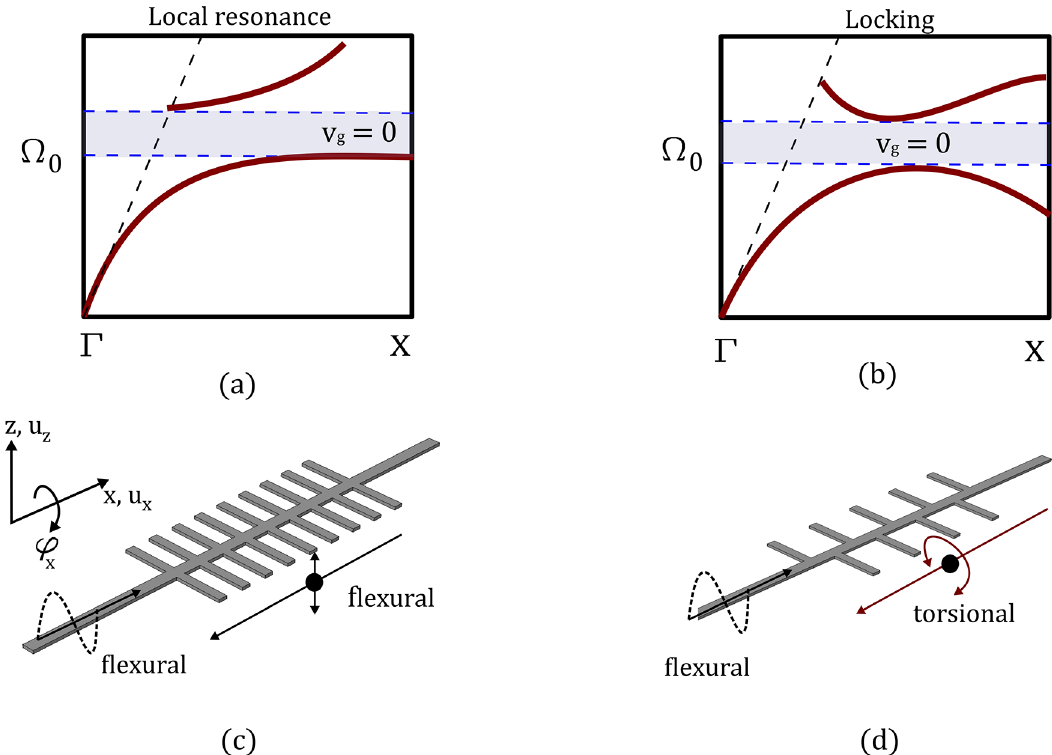
Fig. 2. (a) Dispersion relation for a periodic array of resonators placed symmetrically with respect to the wave propagation direction ( x ). A local resonance bandgap opens at the frequency V 0 due to the coupling between the propagating wave on the waveguide and the resonant mode of the resonators. The bandgap opens at the edge of the Brillouin Zone, with a relatively large zero-group velocity region. (b) Dispersion relation for aperiodic array with asymmetric resonators with respect to the wave propagation direction ( x ). In such a case, a zero-group velocity mode arise within the Brillouin Zone due to the coupling between fl exural ( z -polarized) and torsional ( f z -polarized) waves with opposite group velocity. (c,d) Arrangement of resonators corresponding to the dispersion relations in (a) and (b)